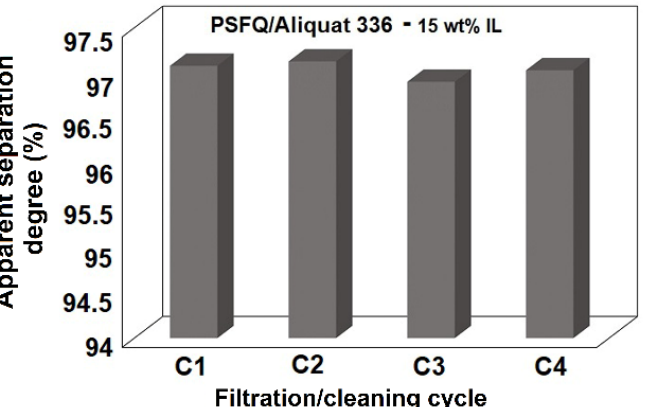
Figure 9. Membrane efficiency developed in 4 filtration/cleaning cycles for treatment process of 50 mL solution containing 3 mg·L −1 DCF.